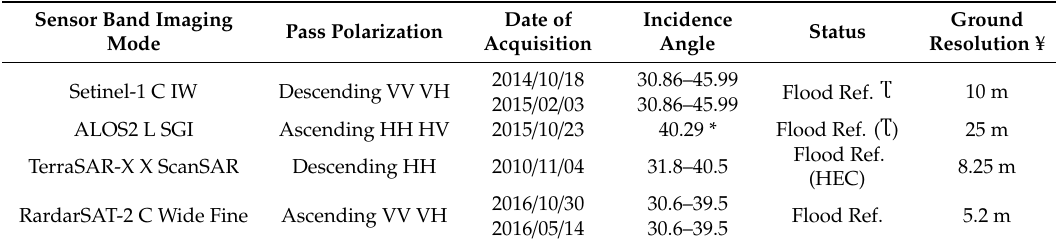
Table 2. Fundamental information of the used SAR images.